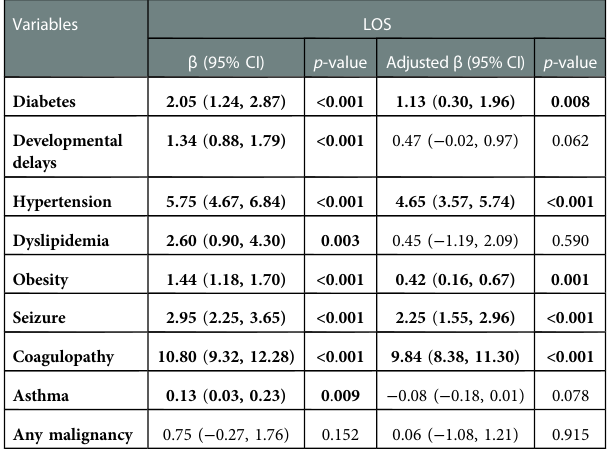
TABLE 2 Comorbidities. TABLE 3 Univariate and multivariate analysis of associations between comorbidities and LOS.